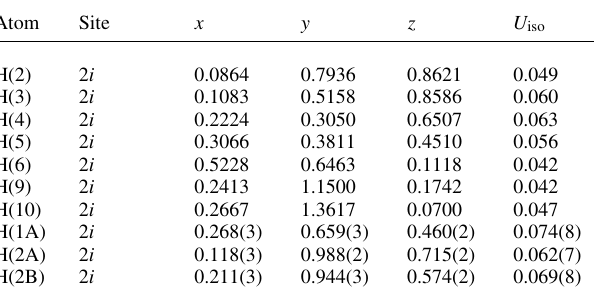
Table 2. Atomic coordinates and displacement parameters (in Å 2 )